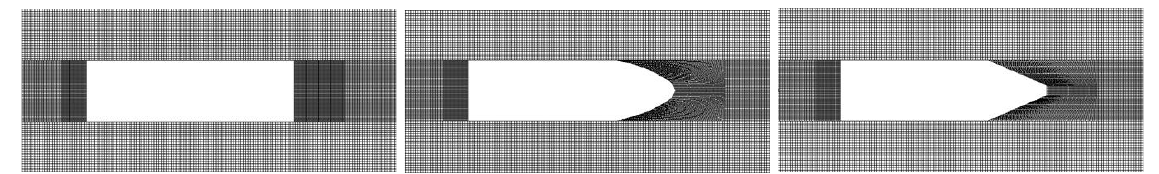
Figure 2. Mesh around the projectile.